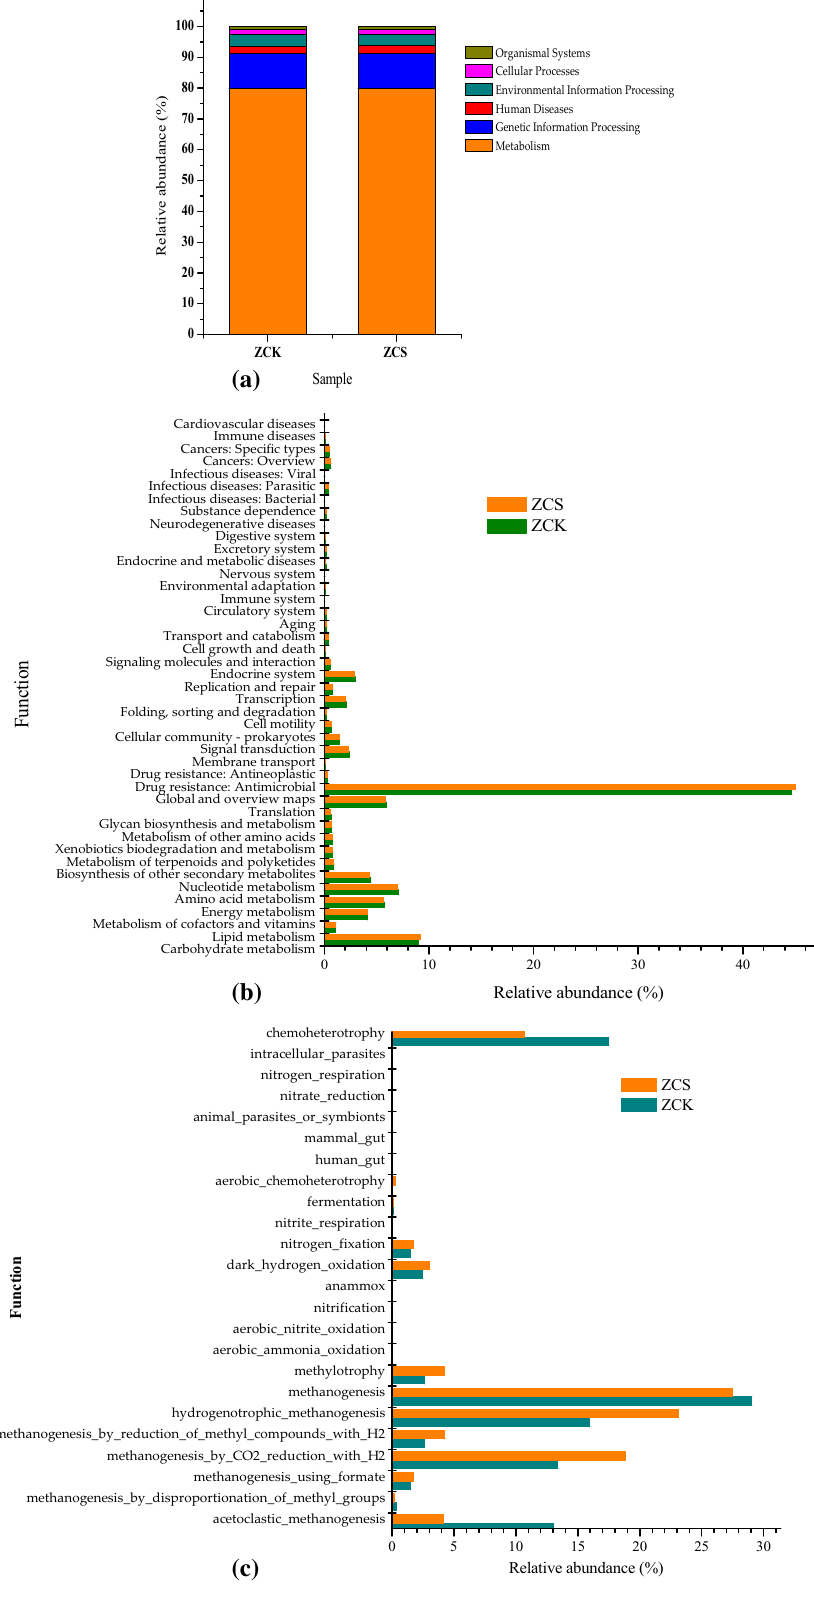
Figure 7. ( a ) Functional notes of archaea KEGG at level 1; ( b ) Functional notes of archaea KEGG at level 2; ( c ) Fapotax diagram of